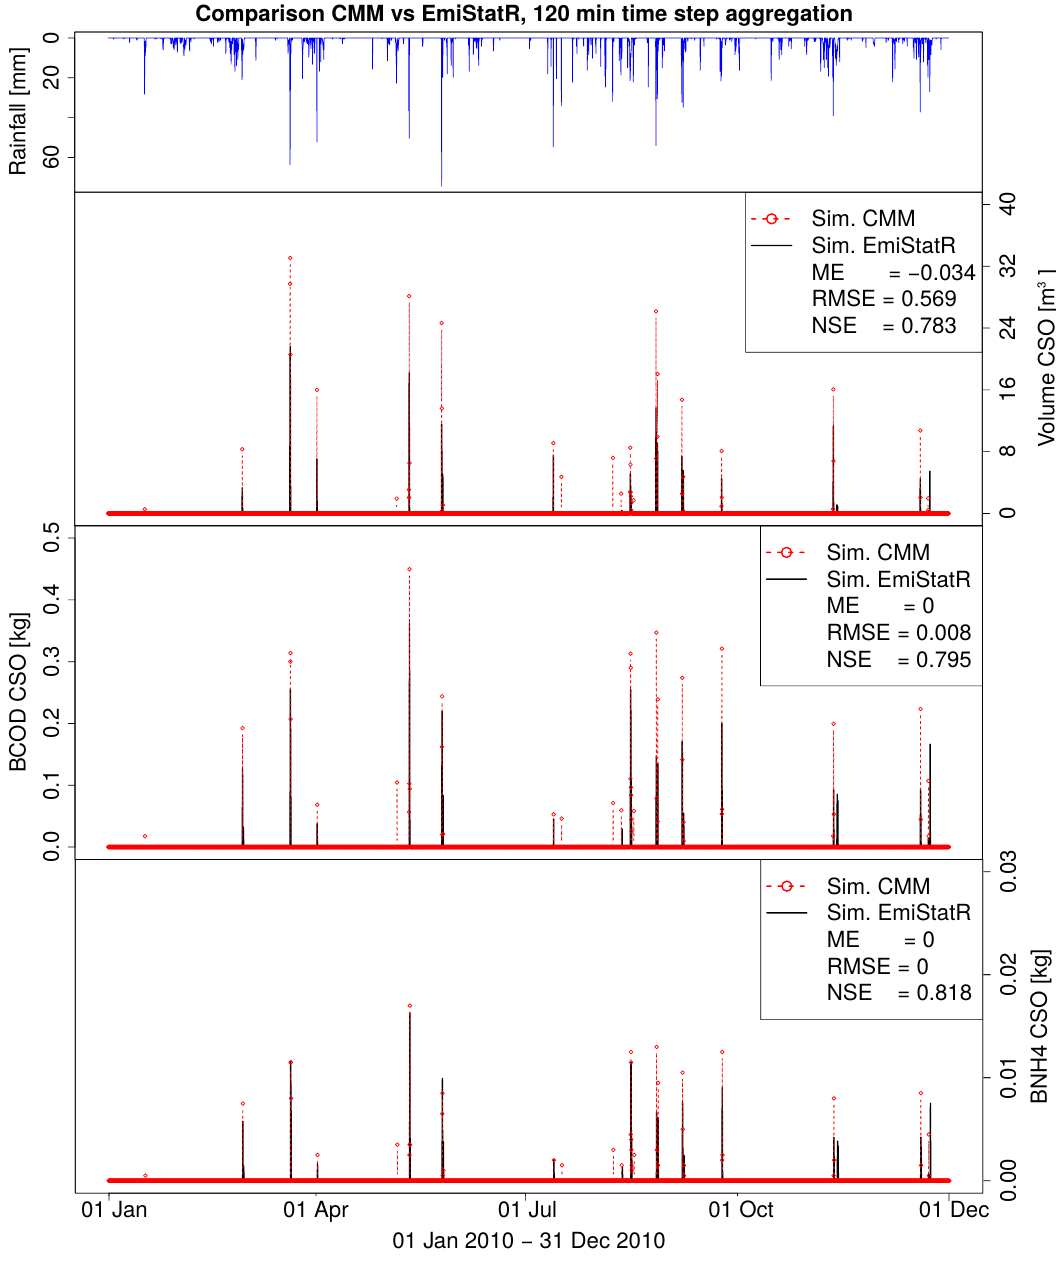
Figure 5. Rainfall ( top ), CSO volume ( second ), chemical oxygen demand (COD) load ( third ), and NH 4 load ( bottom ). January to December 2010 time series (Esch-sur-Sûre rain gauge) for validation of EmiStatR using output of a complex mechanistic model (CMM). Simulation at 10 min resolution at Goesdorf; results aggregated to 120